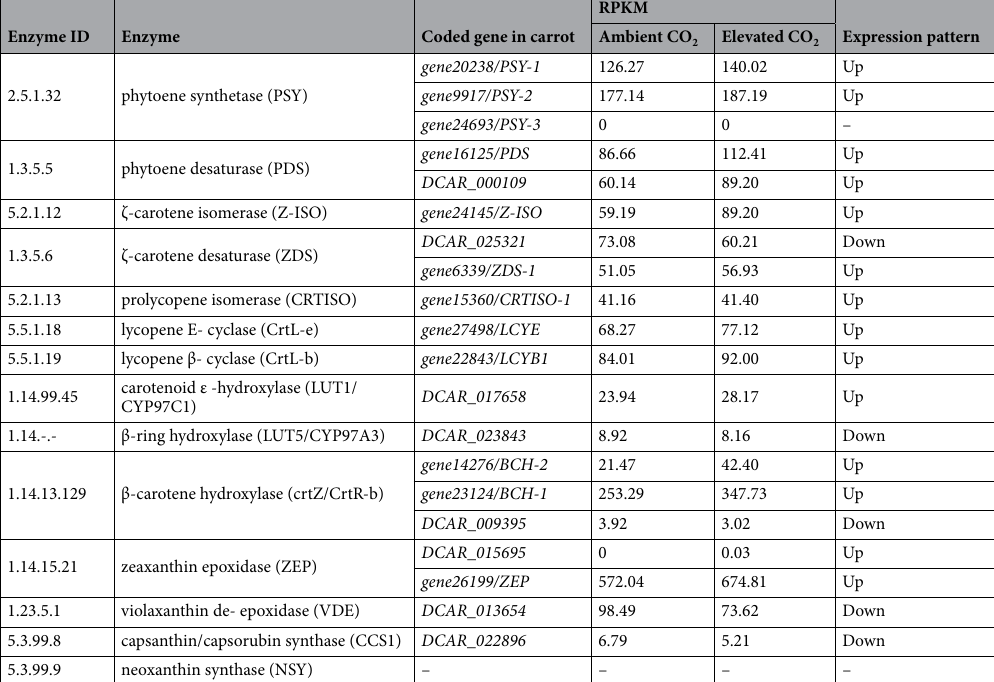
Table 4. Enzymes and coded genes of carotenoid